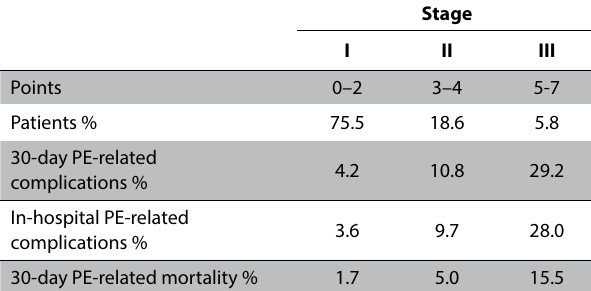
Table 5: The Bova staging system 14